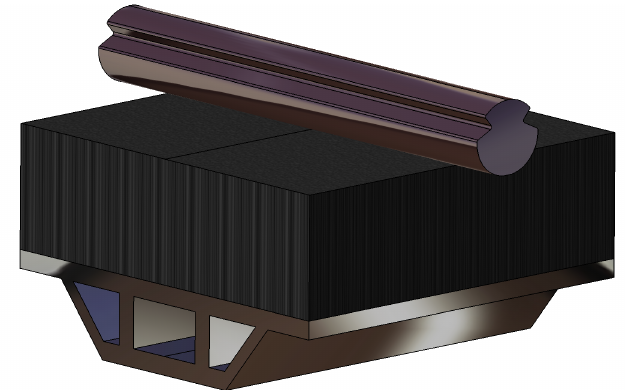
Figure 5. Fragment of contact–contact wire and contact strip–CAD model.